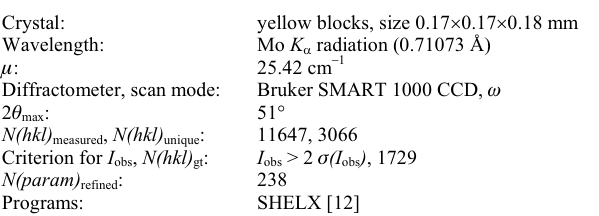
Table 1. Data collection and handling.